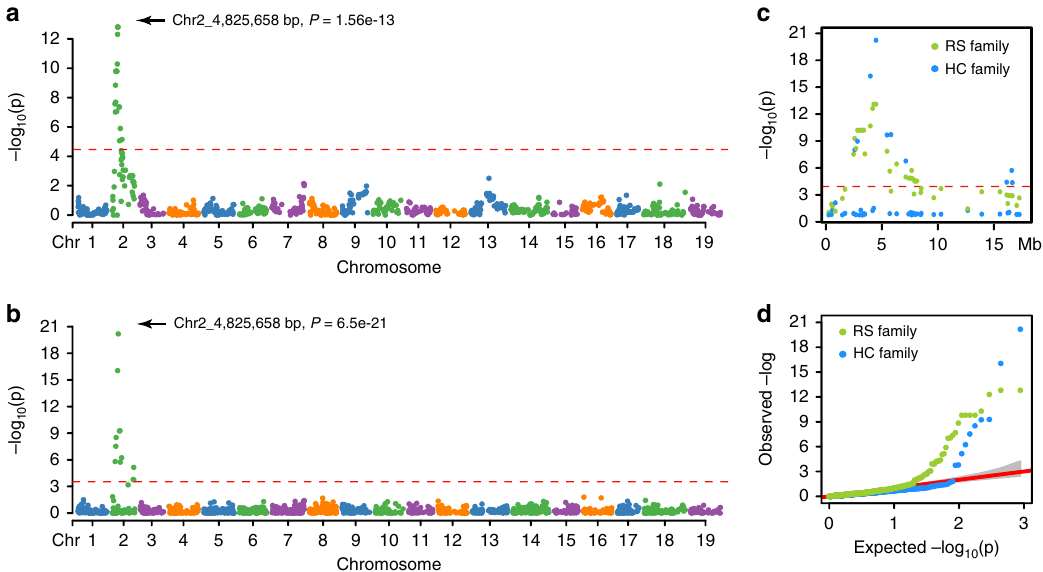
Fig. 5 Association mapping of fl ower sex loci in the RS and HC families. a , b Manhattan plot of GWAS results for fl ower sex in the RS and HC families, respectively. Bonferroni threshold at 4.5 ( α = 0.05) is shown in dotted red line. c The p -values on chromosome 2 only. d QQ-plot for the fl ower sex GWAS analysis in the RS and HC families. Source data are provided as a Source Data fi